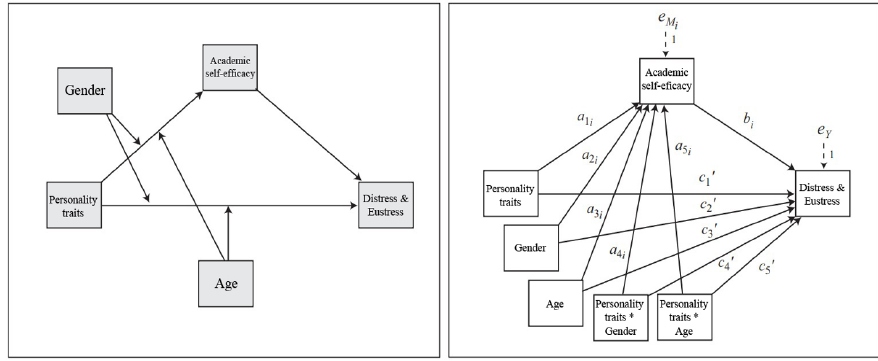
Conceptual and statistical diagram of hypothesized moderated